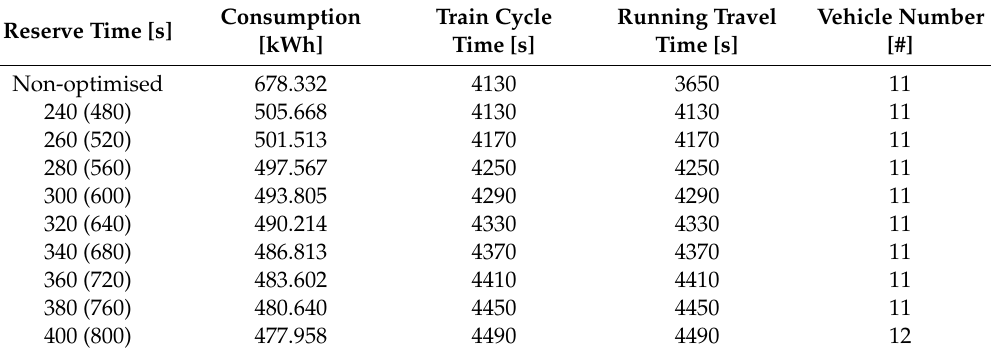
Table 5. Results with di ff erent reserve times (for both